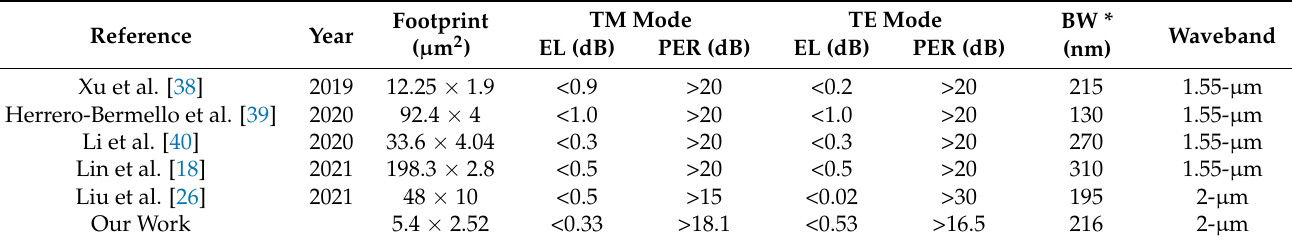
Table 1. The comparison of reported ultra-broadband PBSs.